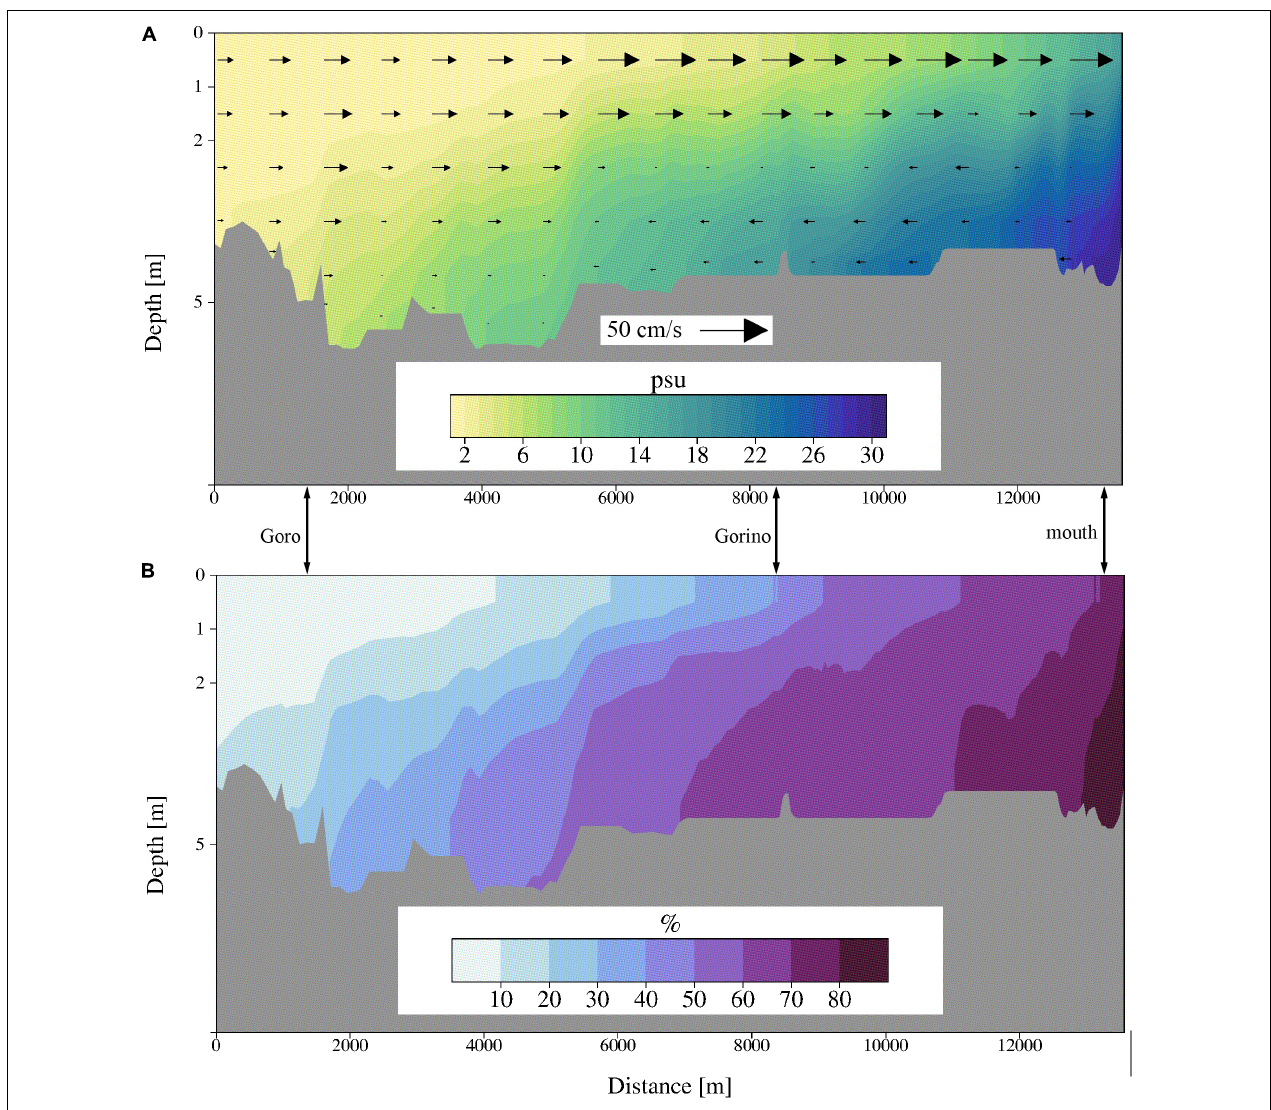
FIGURE 9 | (A) Period July–October 2018: average salinity along the axis of the Po di Goro branch and superimposed average current. (B) Percentage of salinity values higher than 2 PSU along the axis of the Po di Goro branch during the 2018 year. Distances in m are from upstream to the river mouth.